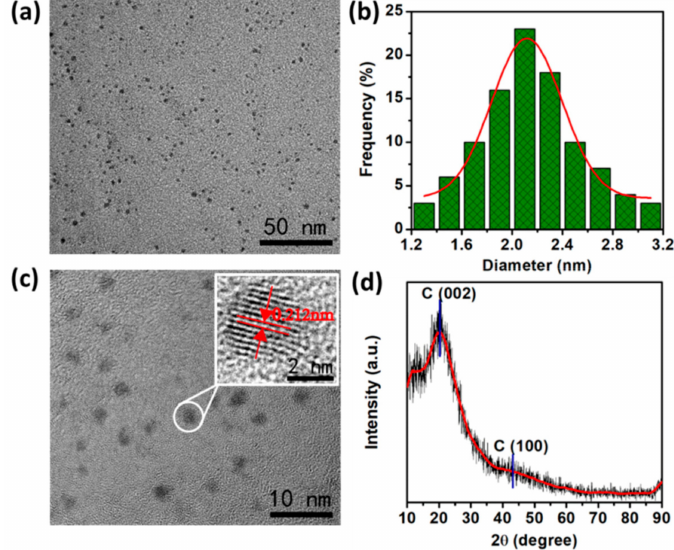
Figure 1. ( a ) TEM image, ( b ) size distribution histogram, ( c ) high-resolution transmission electron microscopy (HRTEM) image, and ( d ) XRD pattern of N-CQDs. The inset of (c) shows the HRTEM image of N-CQDs with lattice parameters of 0.212